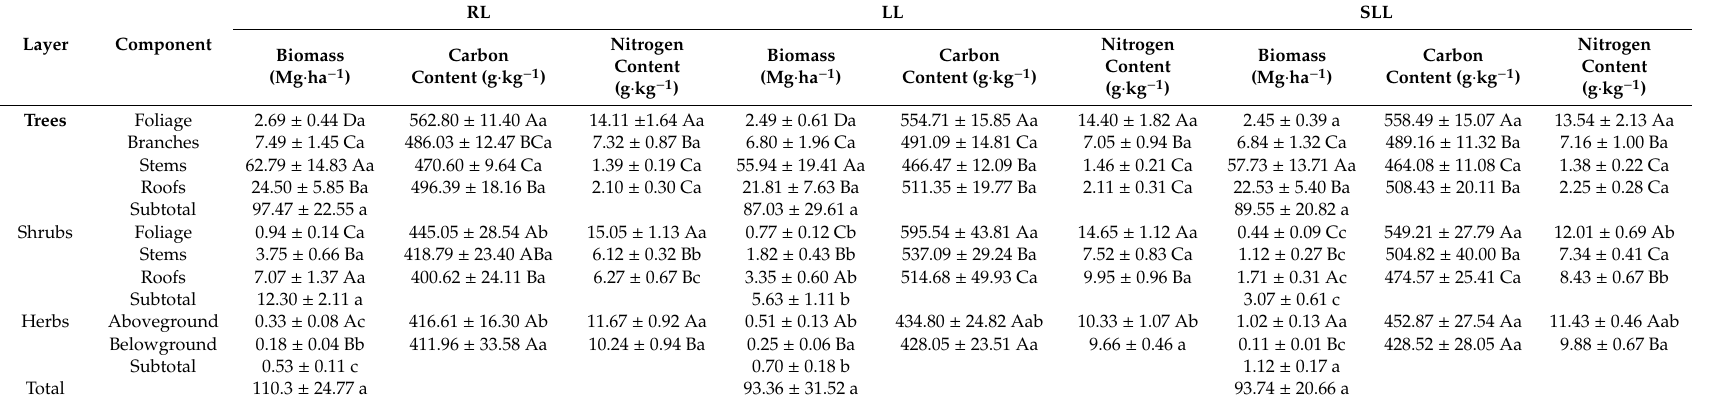
Table A1. Biomass, carbon and nitrogen contents in vegetation layers.